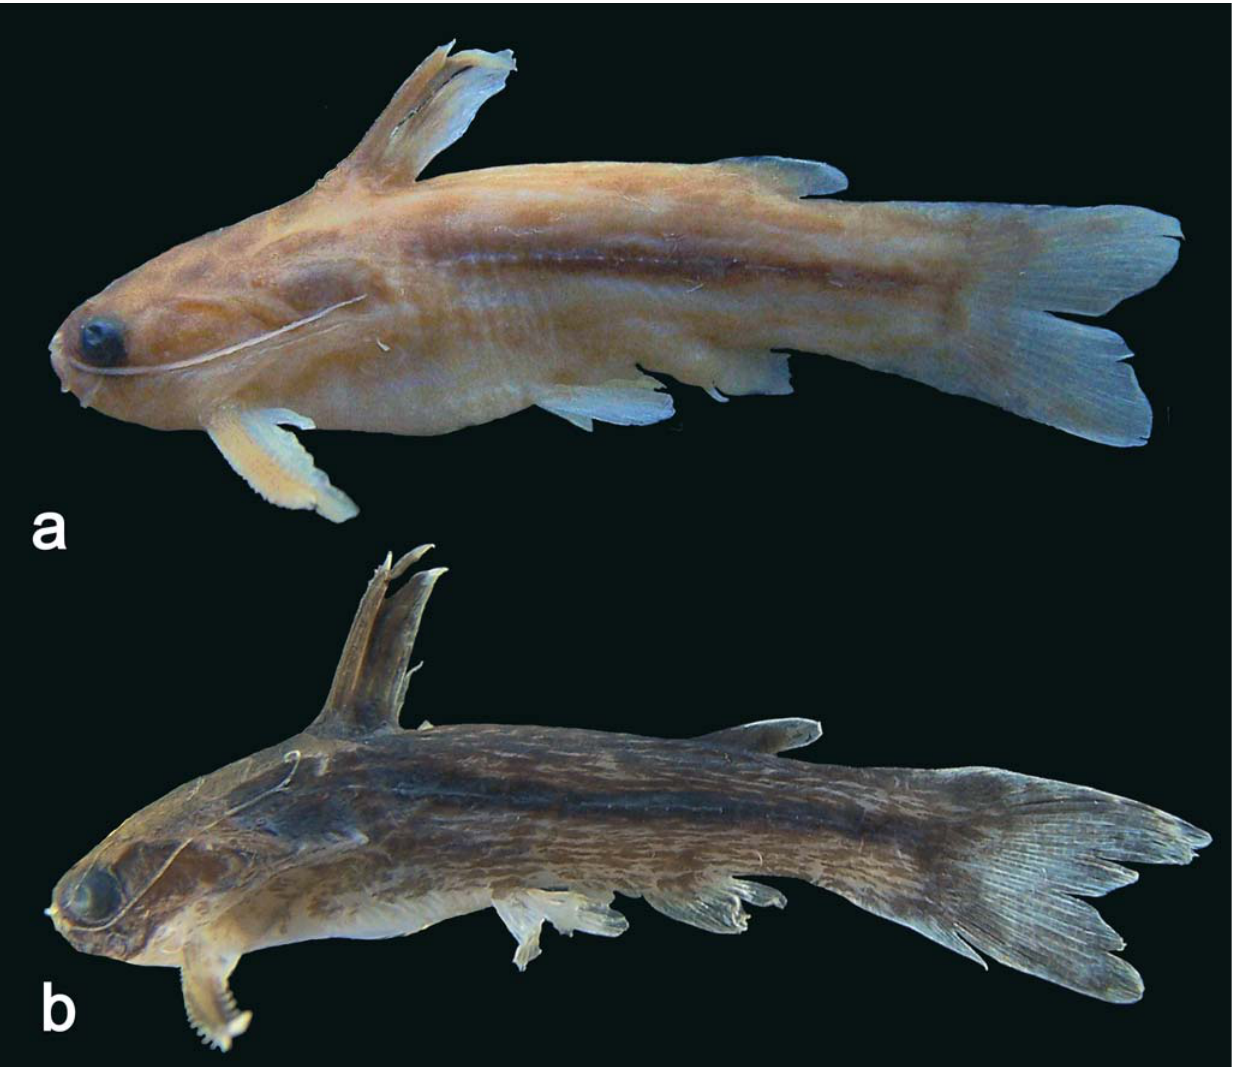
Fig. 25. Tatia gyrina . (a) ZMA 105.859, male, 30.1 mm SL, Carolina stream, Suriname. (b) INPA 20971, female, 26.0 mm SL, Tefé, Amazonas State,